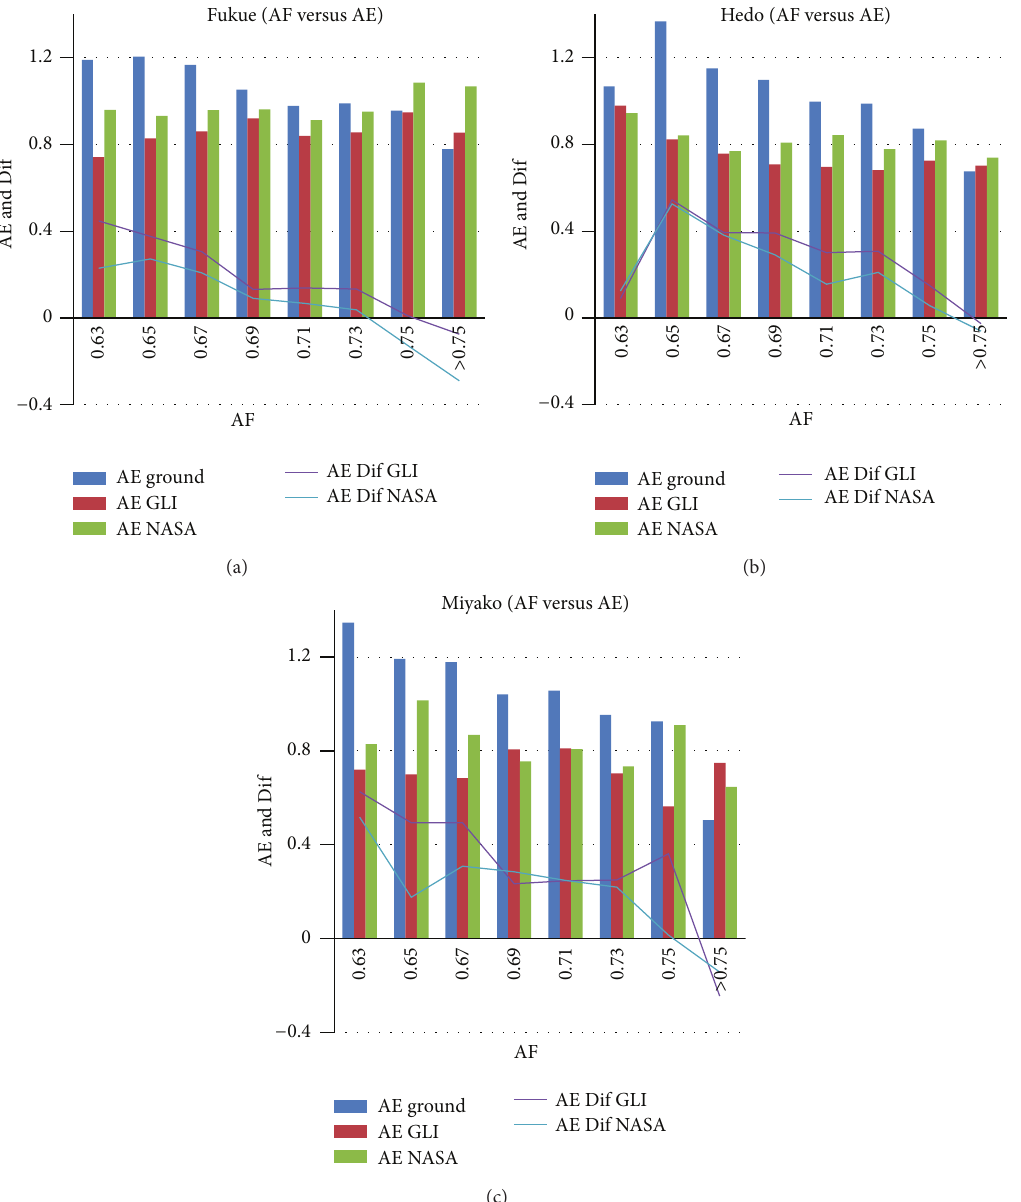
Figure 9: Aerosol asymmetry factor (AF) histogram distribution against AE and the satellites’ algorithms AE, and the difference ground-